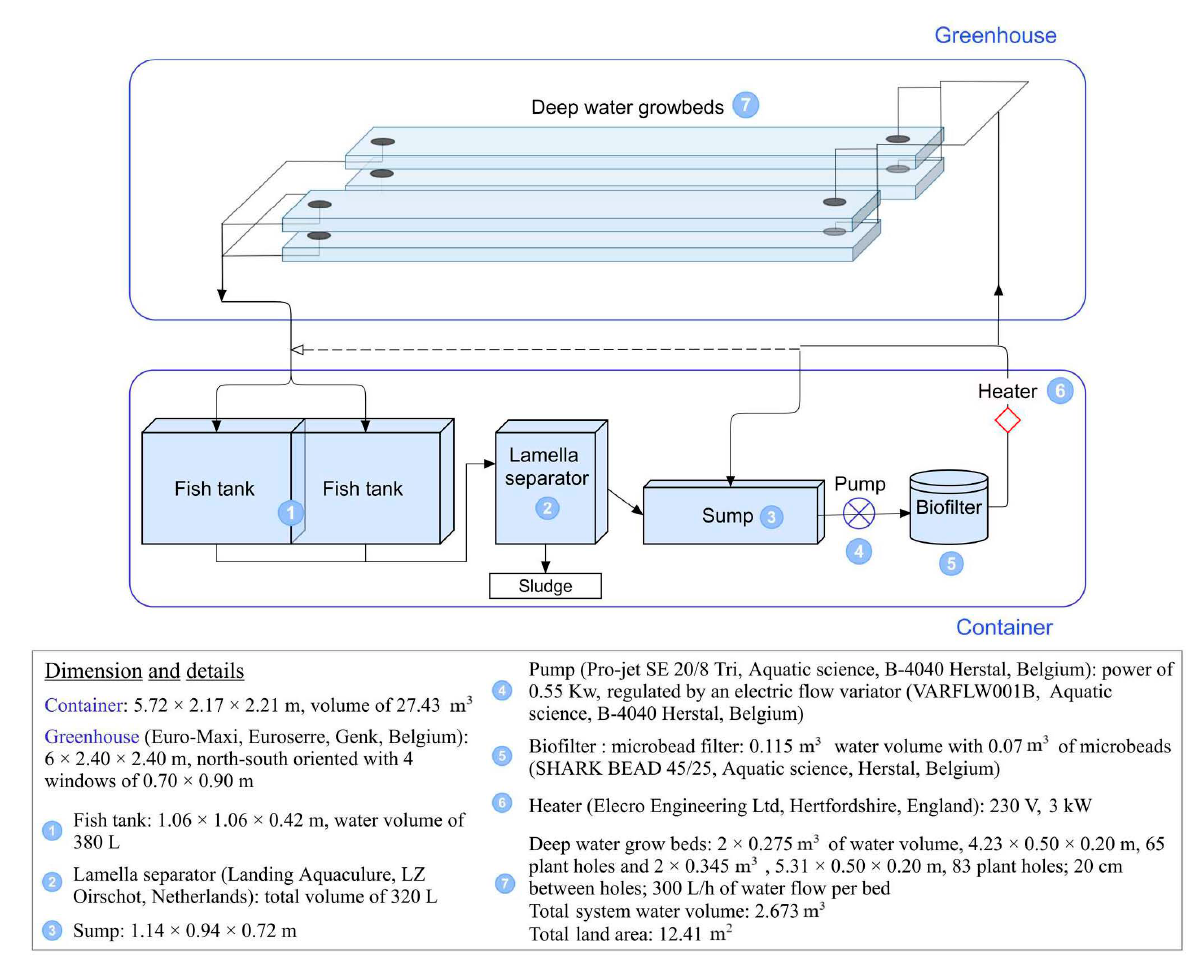
Figure 1. Water flow in the closed-loop aquaponic system of Gembloux Agro-Bio Tech, i.e., the PAFF Box .